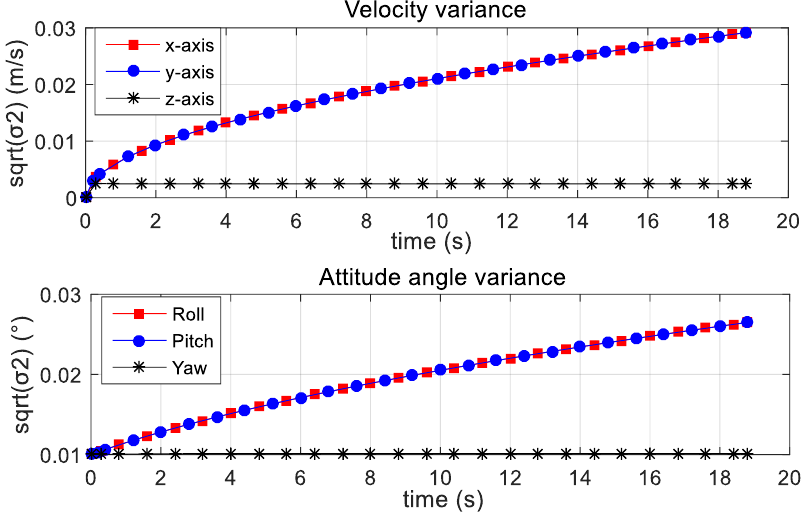
Figure 21. Velocity variance and attitude angle variance results.